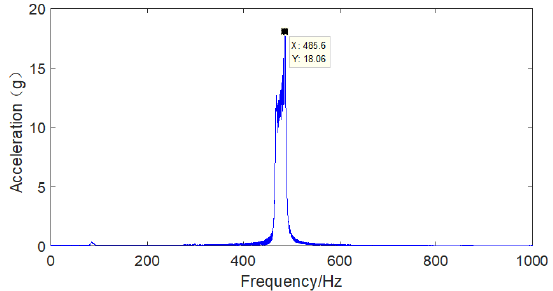
Figure 22. Frequency sweep first-order resonance response of uncoated stainless steel.